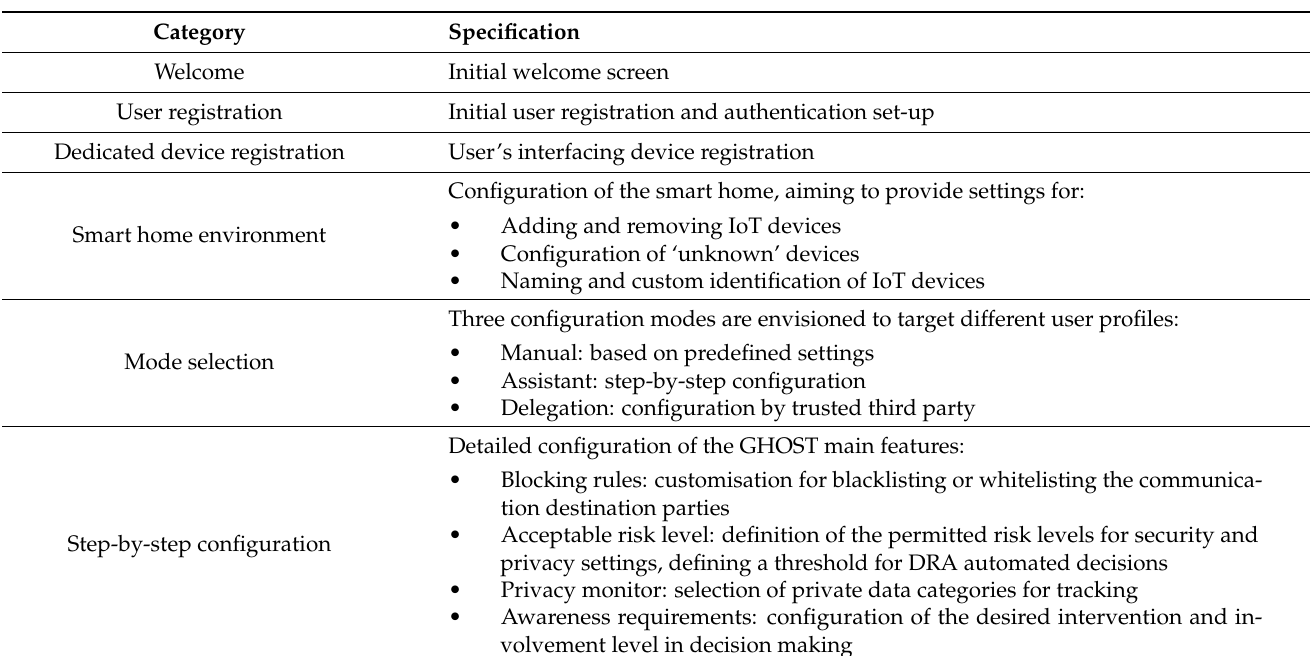
Table 10. Configuration interface: initial set-up.